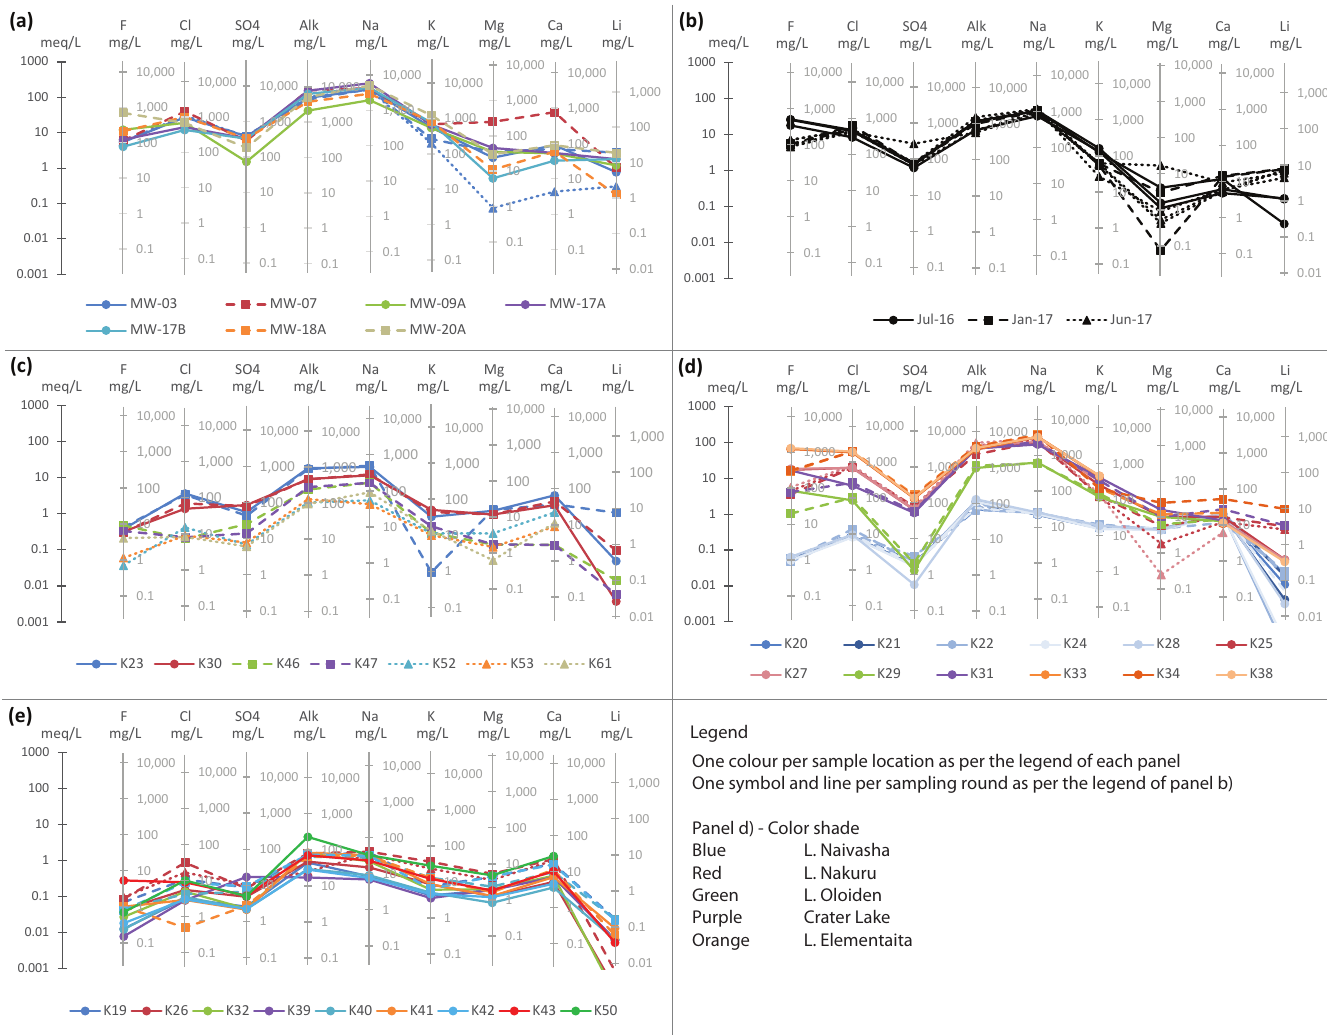
Figure 6. Schoeller diagrams. ( a ) Menengai wells; ( b ) Kikopey hot springs; ( c ) boreholes and cold springs; ( d ) lakes; ( e )